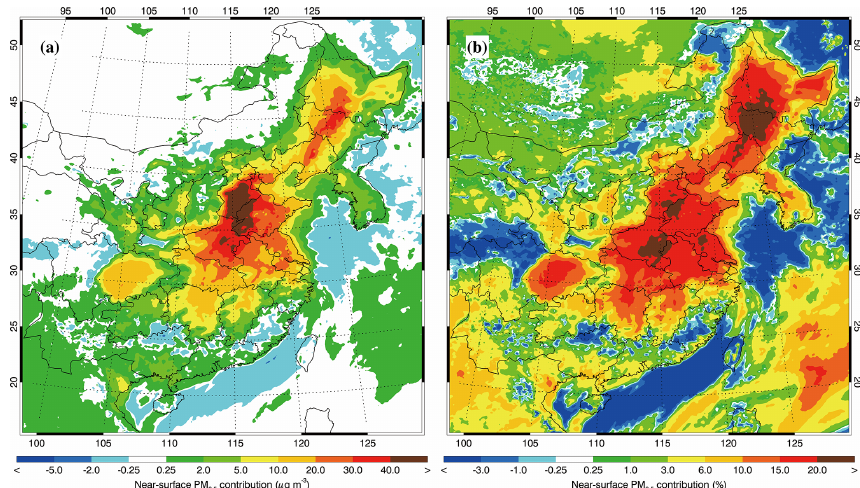
Figure 18. Average near-surface (a) absolute and (b) relative PM 2 . 5 contribution caused by the ALW-TOT from 5 December 2015 to 4 January 2016.